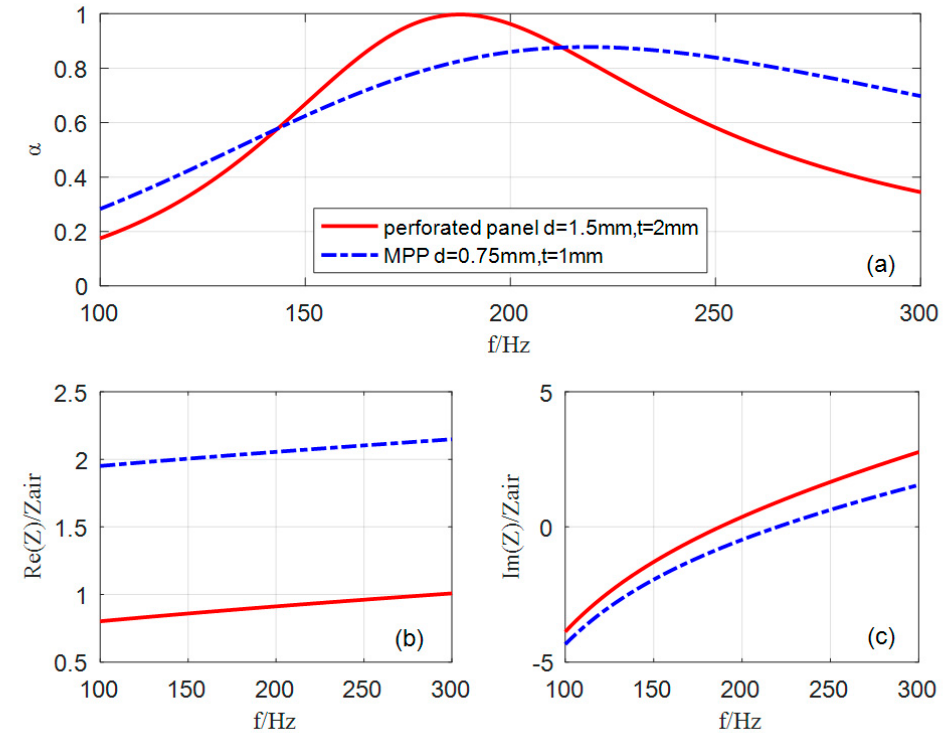
Figure 2. Comparison of the sound absorption of single perforated panel and MPP: ( a ) sound absorption coe ffi cient; ( b ) normalized acoustic resistance; ( c ) normalized acoustic reactance. The parameters of the single optimized perforated panel are as follows: d = 1.5 mm, t = 2 mm, D = 100 mm and p = 0.46%; the parameters of the single optimized MPP are as follows: d = 0.75 mm, t = 1 mm, D = 100 mm and p = 0.33%.